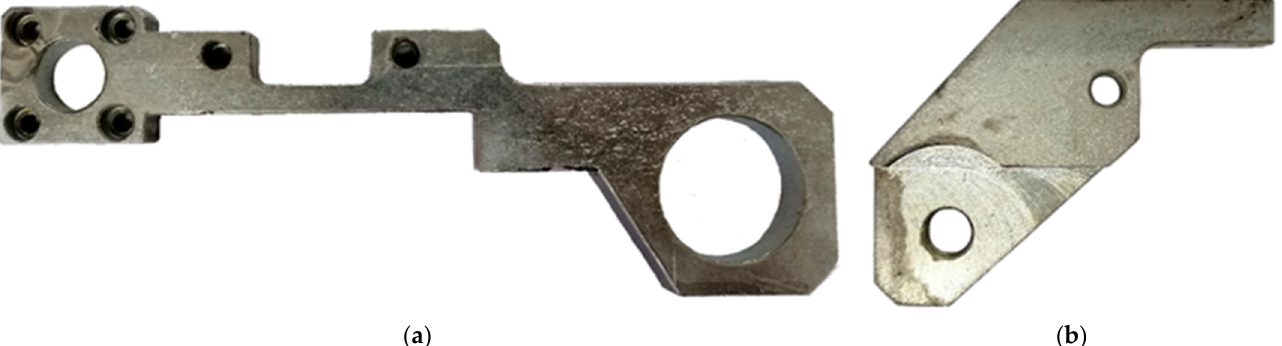
Figure 19. Example of fabricated parts for the equipment modification: proximity sensor support ( a ) and target support ( b ).